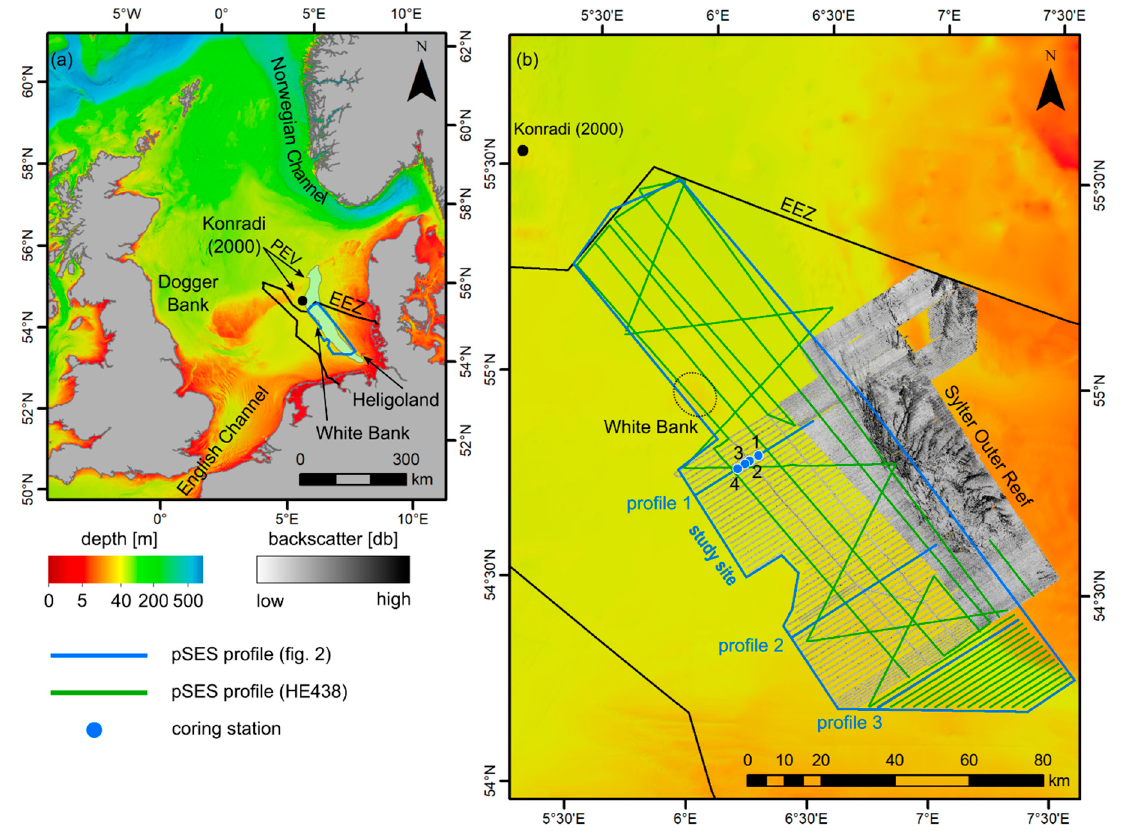
Figure 1. Overview map showing the study area. ( a ) Bathymetry from the present North Sea of the EMODnet data portal [13] with the course of the paleo Elbe valley (PEV) predicted by Konradi [6]. The study site is marked by the blue polygon. ( b ) Study site with backscatter data for the PEV and the western Sylter Outer Reef modified after Papenmeier and Hass [11]. Parametric sediment echosounder (pSES) data exist for all backscatter data (HE400, H415, HE436) and for cruise HE438 (green lines). Profiles 1–3 represent the cross-sections of Figure 2. Coring stations 1–4 are along profile 1.